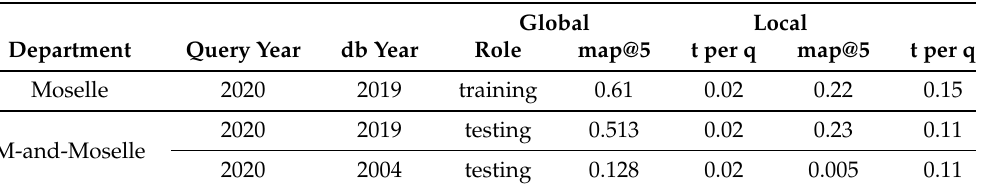
Table 10. The map@5 results for the global and local descriptors, cross-department learning and testing, cross-source data.